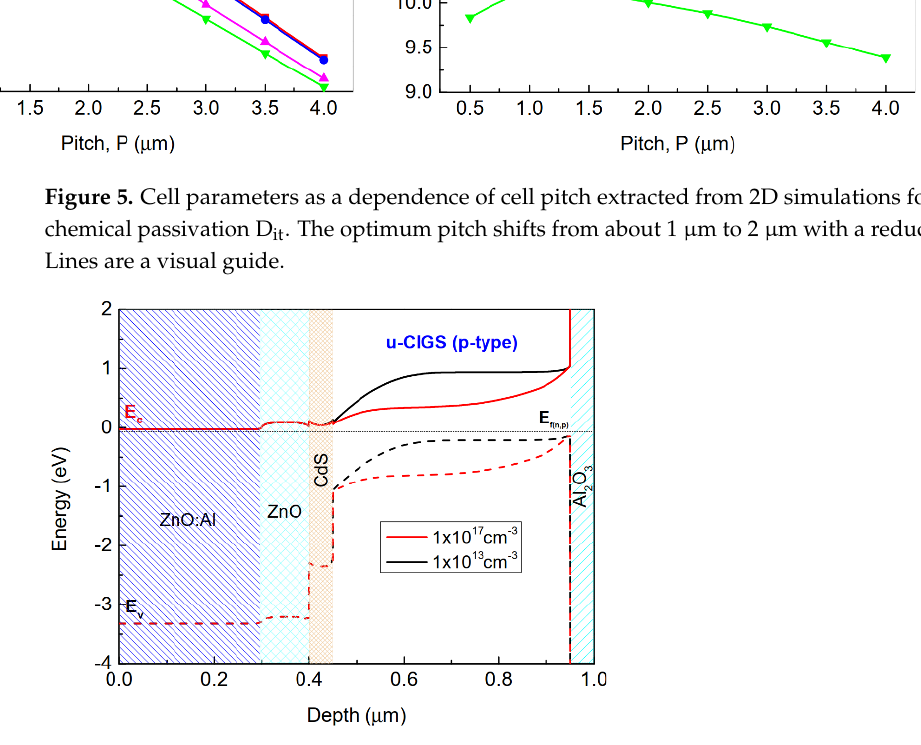
Table 2. PV characteristics with different absorber defect densities at a fixed energy level (0.4 eV). PV Parameters